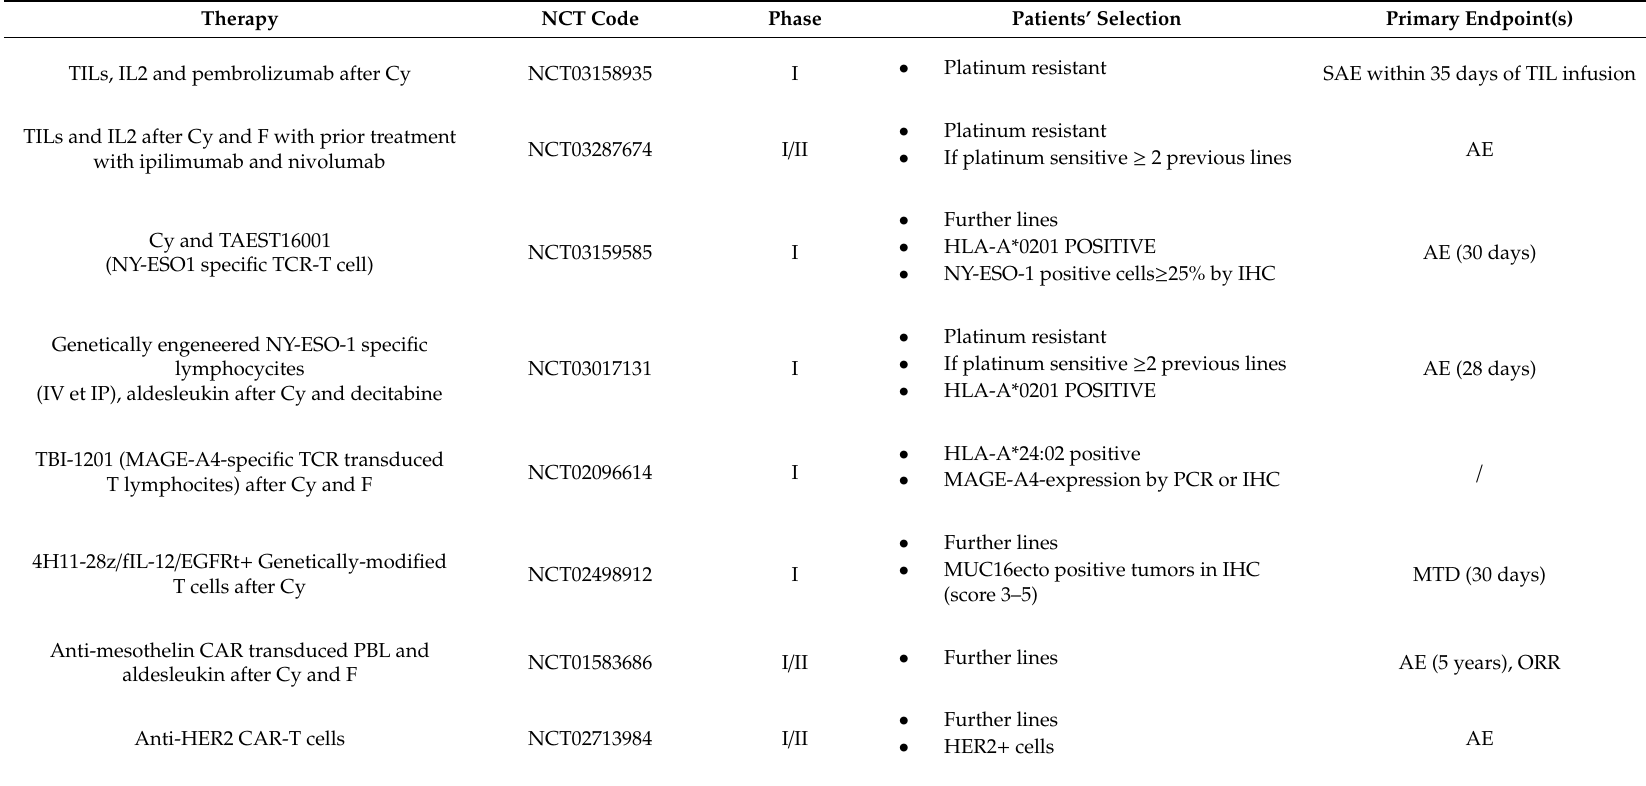
Table 3. Selected trials of adoptive therapies in epithelial ovarian cancer